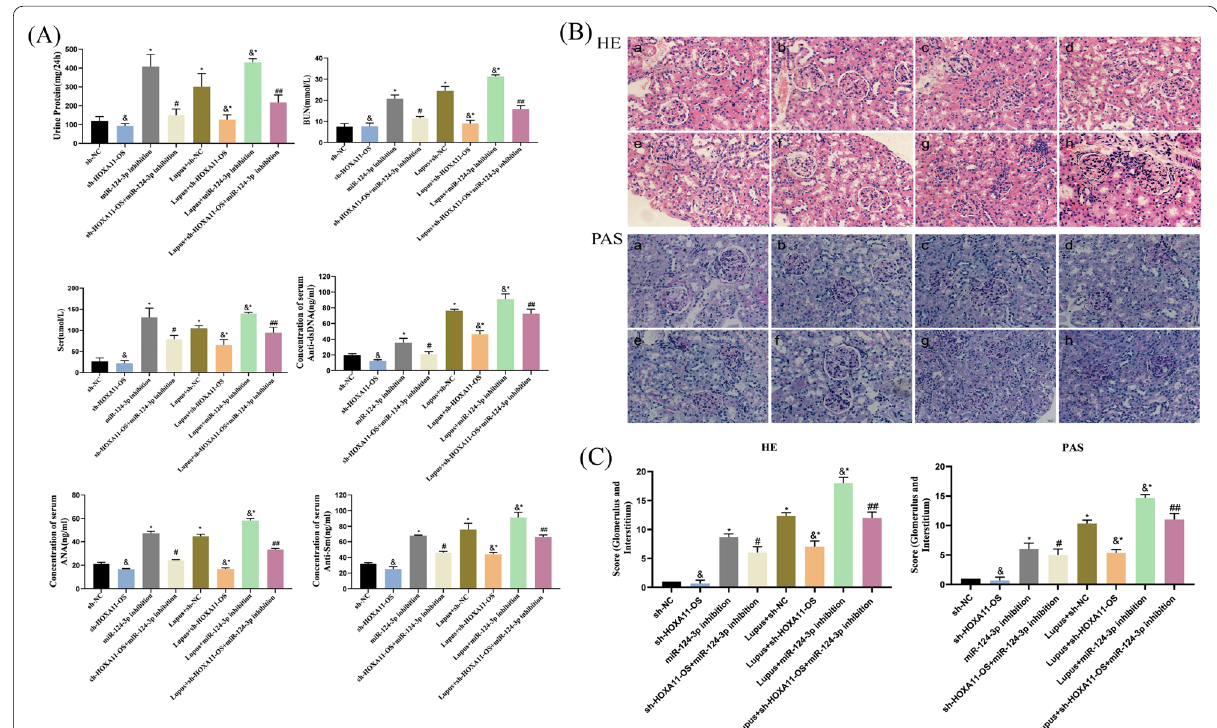
Fig. 6 miR-124-3p inhibition leads to the deterioration of lupus mice but podocyte injury was alleviated after HOXA11-OS knockdown. Levels of 24 h urinary protein, BUN, Scr, and autoantibody in mice in each group. & P > 0.05, * P < 0.05 vs. sh-NC; # P < 0.05 vs. sh-HOXA11-OS; &* P < 0.05 vs. Lupus sh-NC; ## P < 0.05 vs. Lupus sh-HOXA11-OS. B,C hematoxylin–eosin and periodate-Schiff staining and histological score of kidney + + tissues of different groups: a sh-NC; b sh-HOXA11-OS; c miR-124-3p inhibition; d sh-HOXA11-OS miR-124-3p inhibition; e Lupus sh-NC; f + + Lupus sh-HOXA11-OS; g Lupus miR-124-3p inhibition; and h Lupus sh-HOXA11-OS miR-124-3p inhibition. Scale bars represent 20 µm. + + + + & P > 0.05, * P < 0.05 vs. sh-NC; # P < 0.05 vs. sh-HOXA11-OS; &* P < 0.05 vs. Lupus